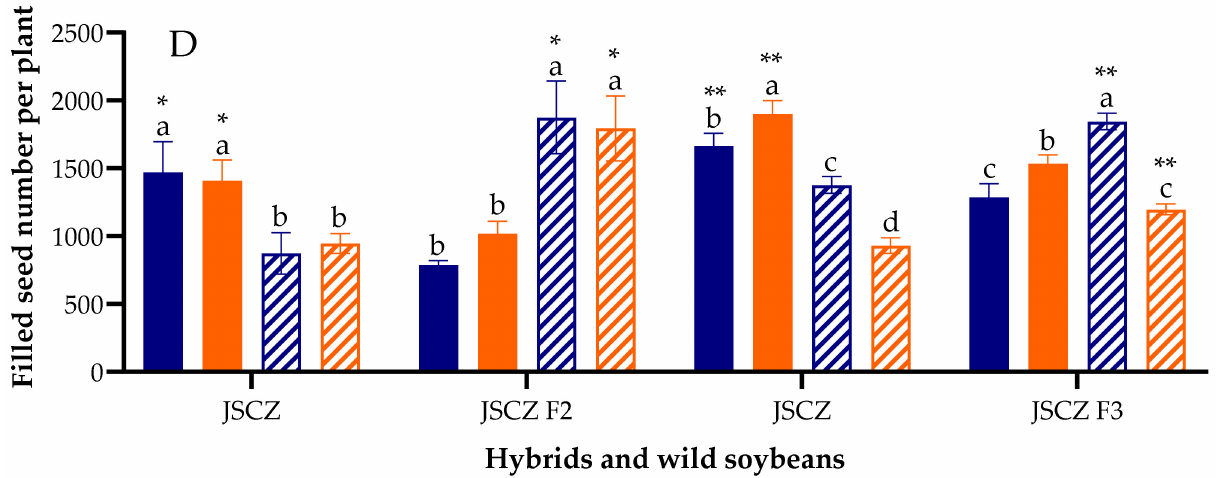
Figure 6. Pod number ( A , B ) and filled-seed number per plant ( C , D ) of hybrids and wild soybeans under four planting condition. Note: * and ** indicate significant difference ( p < 0.05) and extremely significant difference ( p < 0.01) of the same trait between hybrids and their wild soybeans. Different lowercase letters indicate significant difference ( p < 0.05) of hybrids or wild soybeans among four planting conditions.